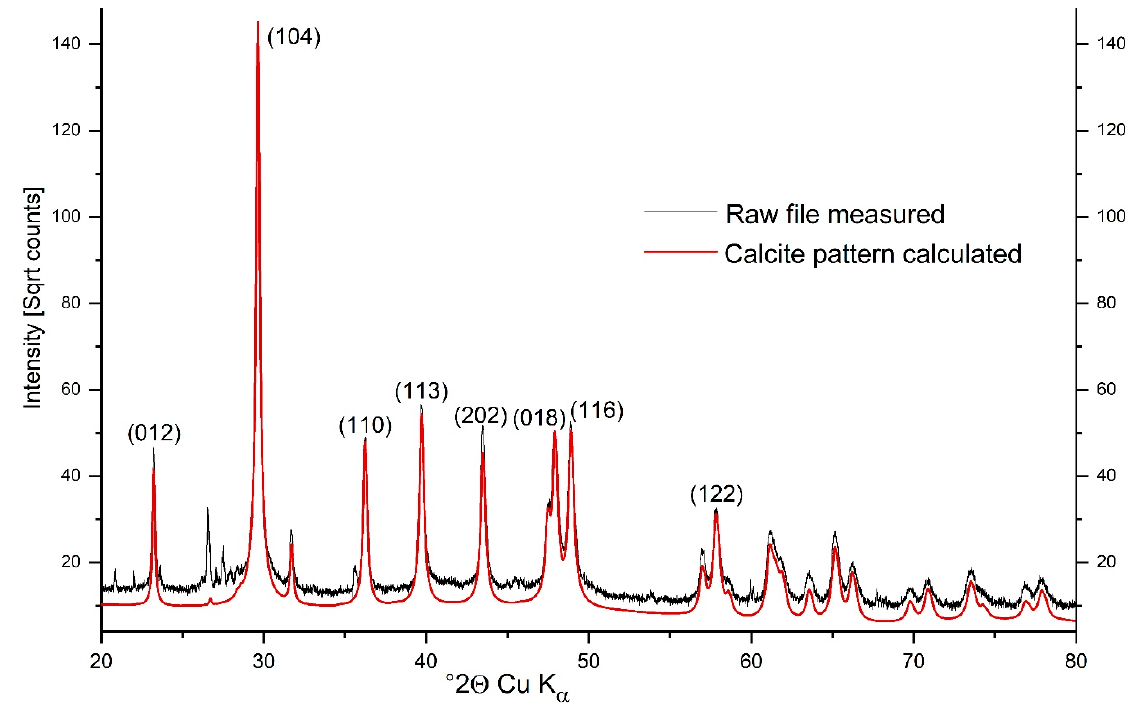
Figure 6. X-ray diffractogram with the characteristic ( hkl )-surfaces indicated for the high-Mg calcite of the mineralized thallus.